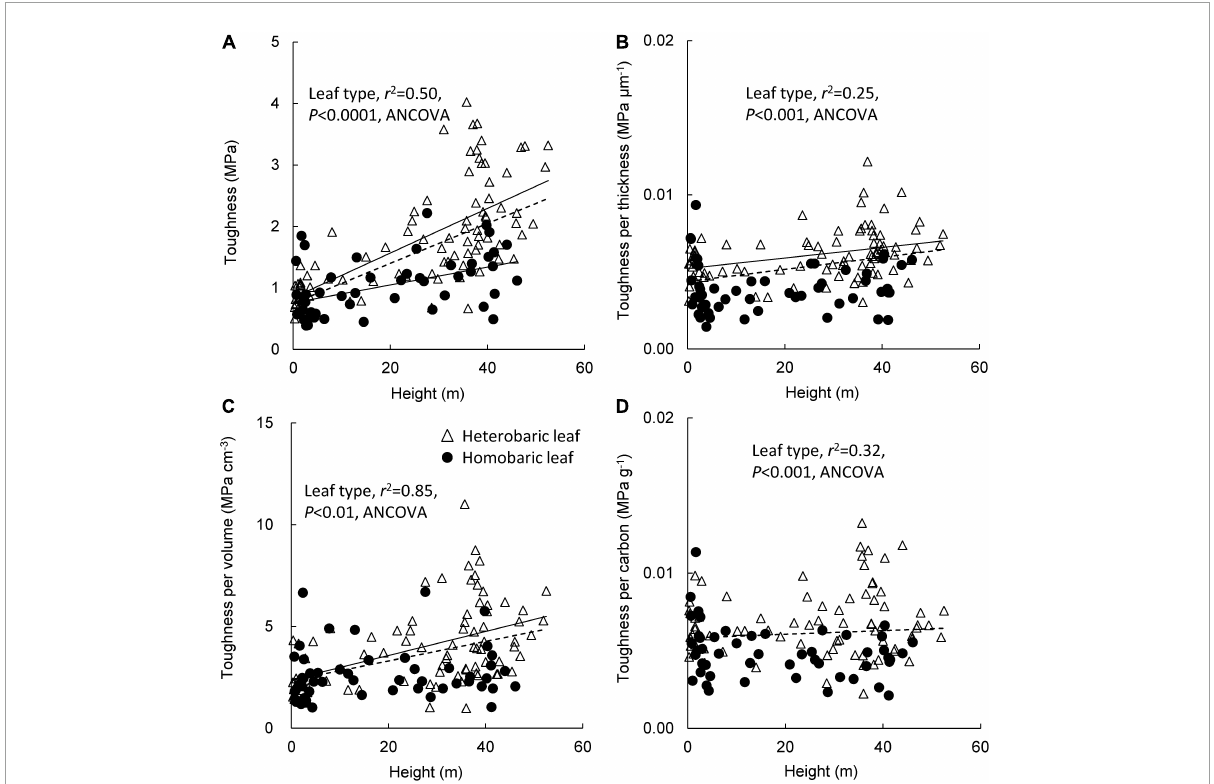
FIGURE2 Changes in leaf toughness (A) , toughness per leaf blade thickness (B) , toughness per leaf blade volume (C) , and toughness per carbon (D) with tree height between heterobaric and homobaric leaf trees. Regression lines are: (A) heterobaric leaf, r 2 = 0.45, P < 0.0001; homobaric leaf, r 2 = 0.24, P < 0.0001; (B) heterobaric leaf, r 2 = 0.12, P < 0.01; homobaric leaf, ns; (C) heterobaric leaf, r 2 = 0.23, P < 0.001; homobaric leaf, ns; (D) heterobaric and homobaric leaf, ns. “ns” means not significant. Details of the results of ANCOVA appear in Appendix 6. Dotted line means regression line for pooled data for both leaf